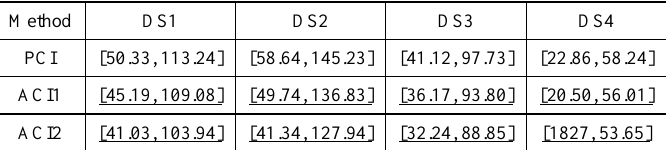
Table 2. The estimation results of model parameter 𝛼 with BS1